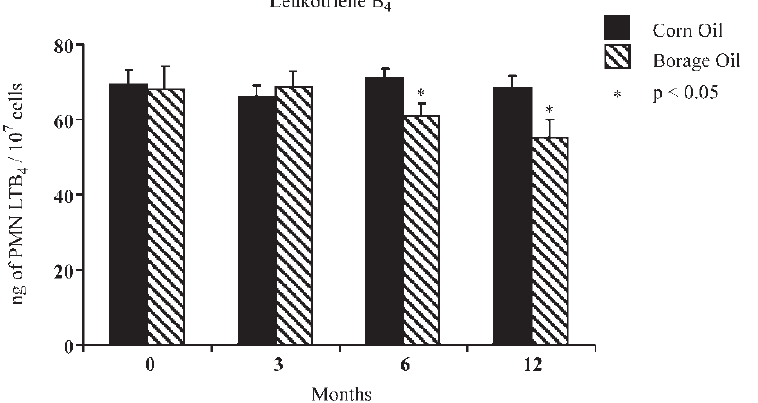
FIGURE 1 Time-dependent effect of dietary GLA supplement on PMN generation of LTB 4 . Blood from asthma patients whose diets were either supplemented with either 2.0g GLA/day as borage oil or placebo corn oil were collected respectively in EDTA at 3-monthly intervals. Neutrophils were isolated as described in the “Methods” section and then stimulated with Ca 2 þ ionophore. The extract was subjected to separation on HPLC to identify and quantify for LTB 4 . Patients whose diets were supplemented with GLA-containing borage oil significantly ( p , 0.05) suppressed Ca 2 þ ionophore- induced PMN generation of LTB 4 . Results are means ^ SEM. Borage oil group is 19 and corn oil group is